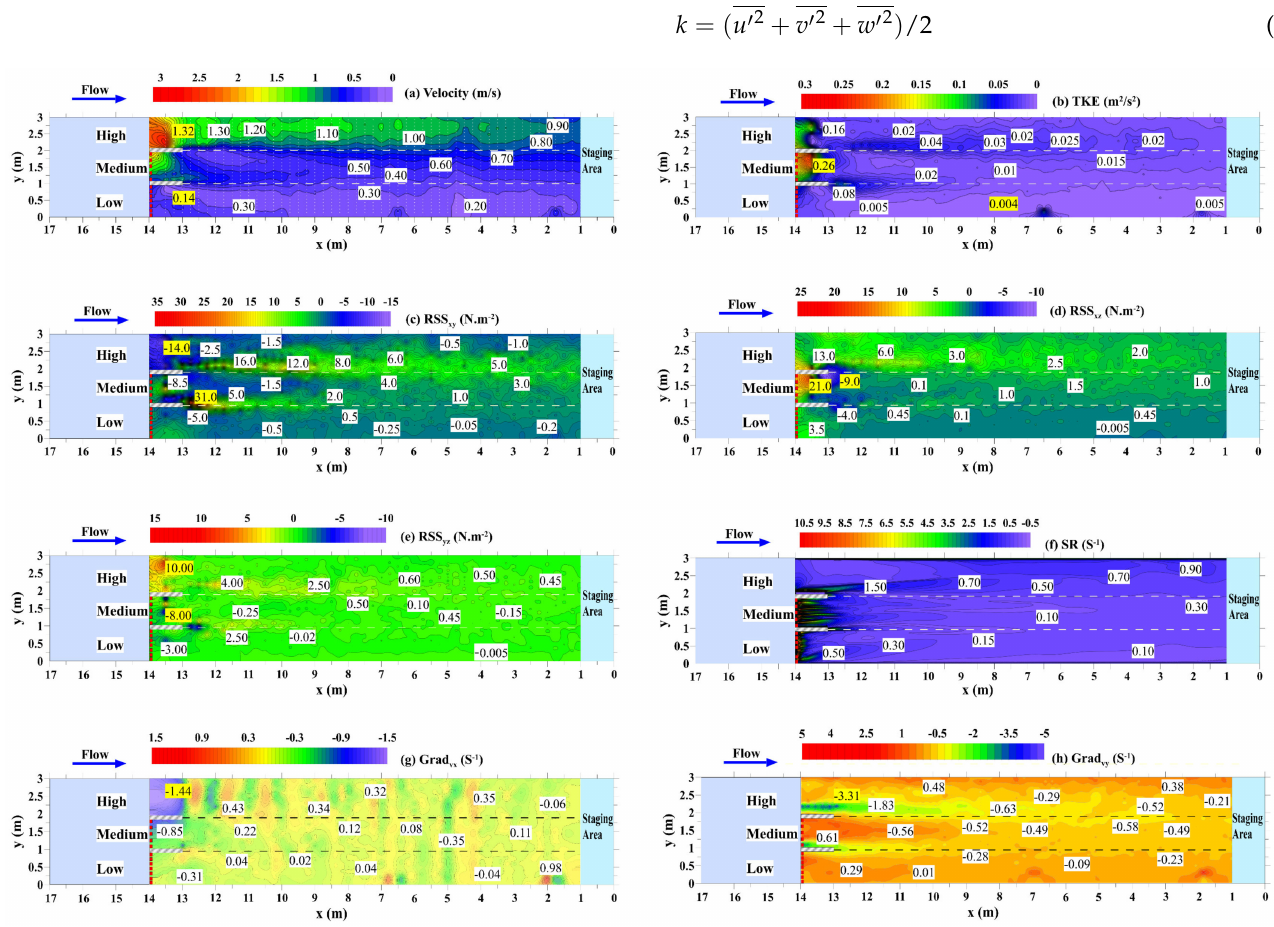
Figure 2. Contour plots of different hydraulic parameters: ( a ) flow velocity (m/s), with the white dots indicating the ADV measurement points and the white dashed lines indicating the flow regime bound- aries; ( b ) turbulent kinetic energy (TKE, m 2 · s − 2 ); Reynolds shear stress in three planes: ( c ) RSS xy , ( d ) RSS xz , and ( e ) RSS yz , N . m − 2 ; ( f ) strain rate (SR, s − 1 ); and ( g ) velocity gradients along (Grad vx , s − 1 ) and ( h ) perpendicular to the direction of water flow (Grad vy , s − 1